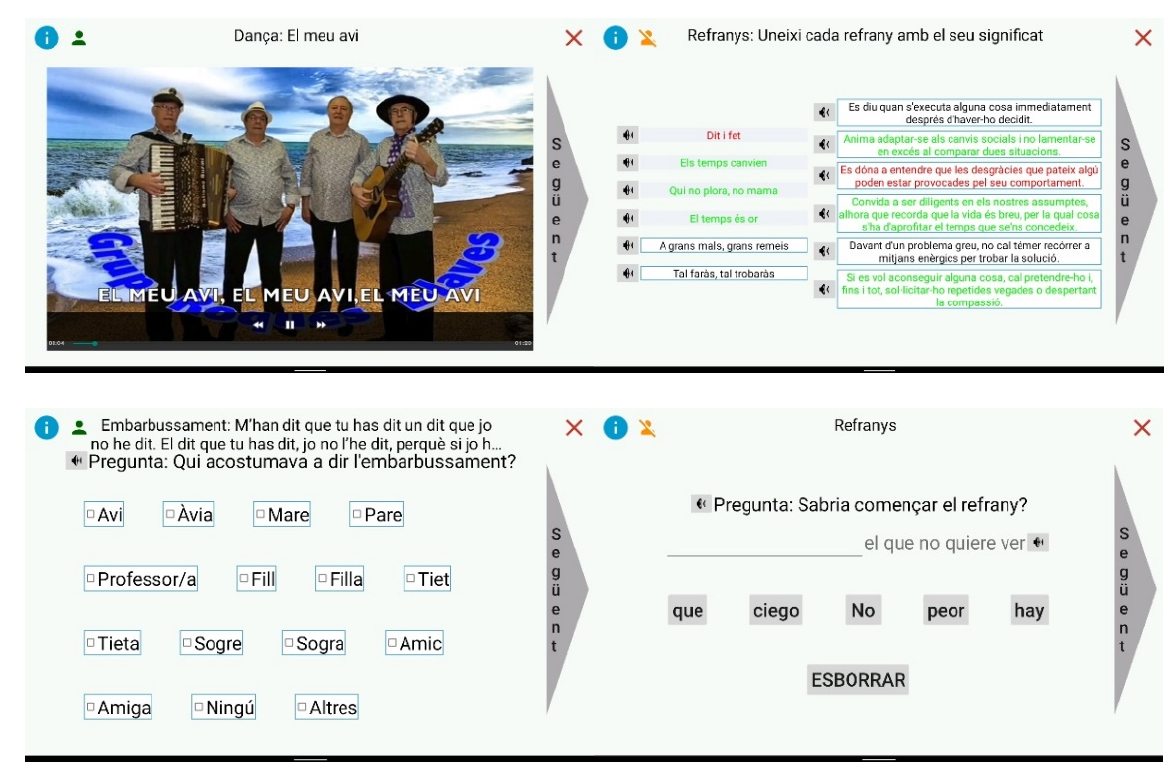
Figure 2. Example of screenshots of the application (in Catalan). The application contains material in Catalan and Portuguese as it is intended for citizens of both countries.